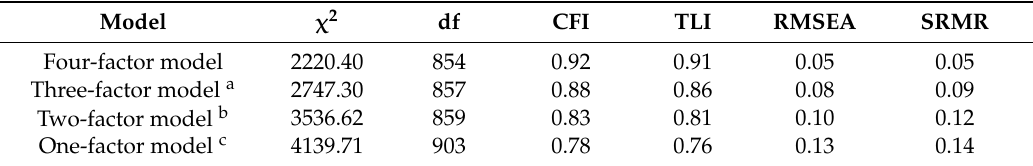
Table 1. Results of confirmatory factor analysis.